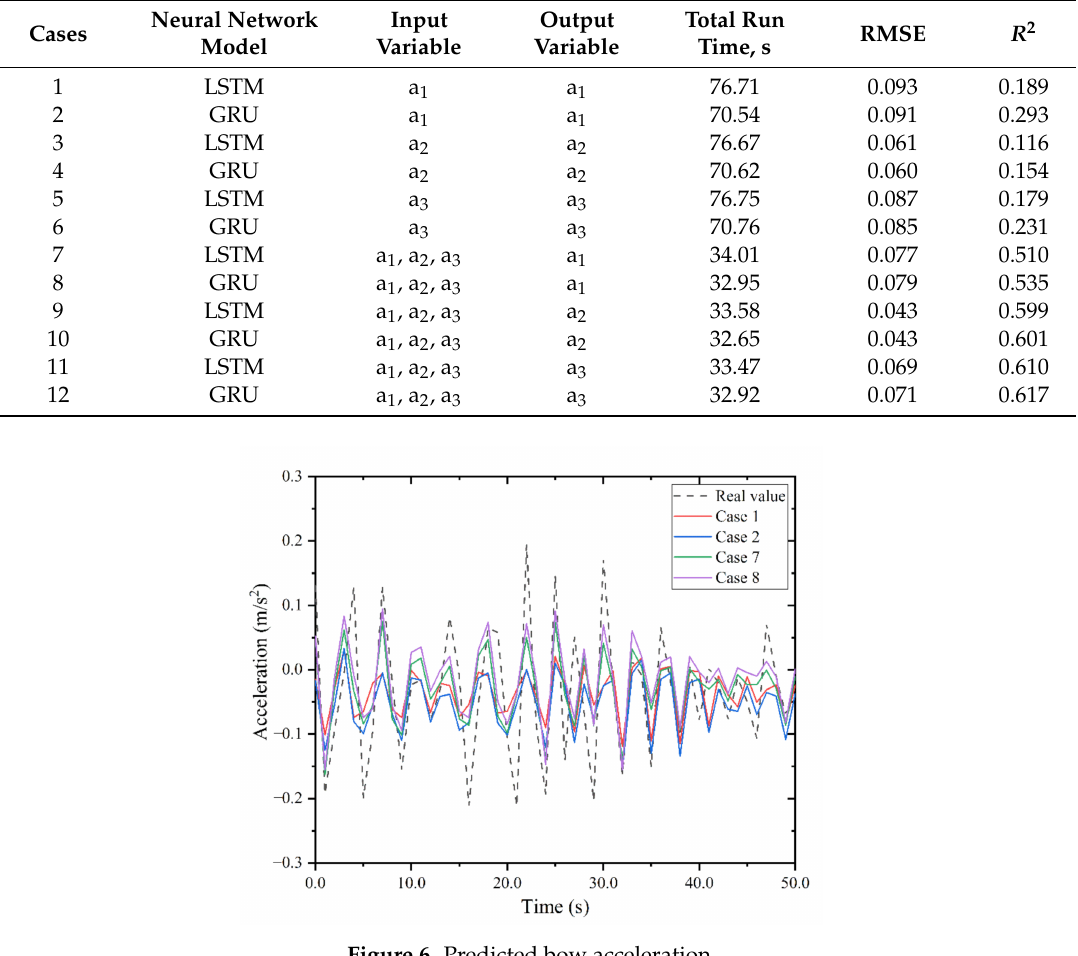
Figure 6. Predicted bow acceleration.